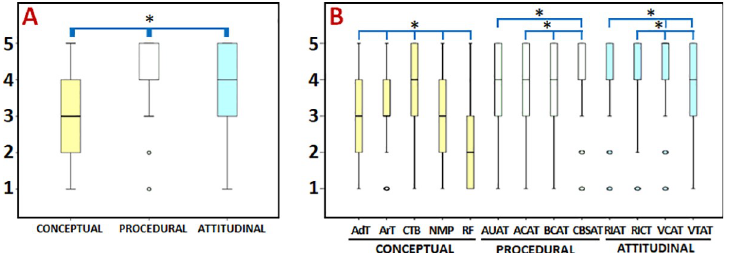
Fig 1. Boxplots of the results for the components and topics analyzed in this study. A: Components. B: Topics. Statistically significant differences (p < 0.00017) are labeled with asterisks ( �